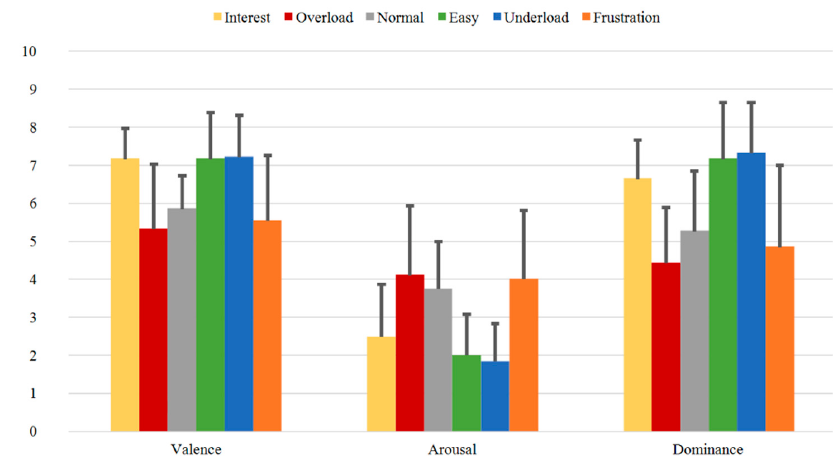
Figure 10. SAM Ratings of Group B2 for all sequences with mean Valence, Arousal, and Dominance.